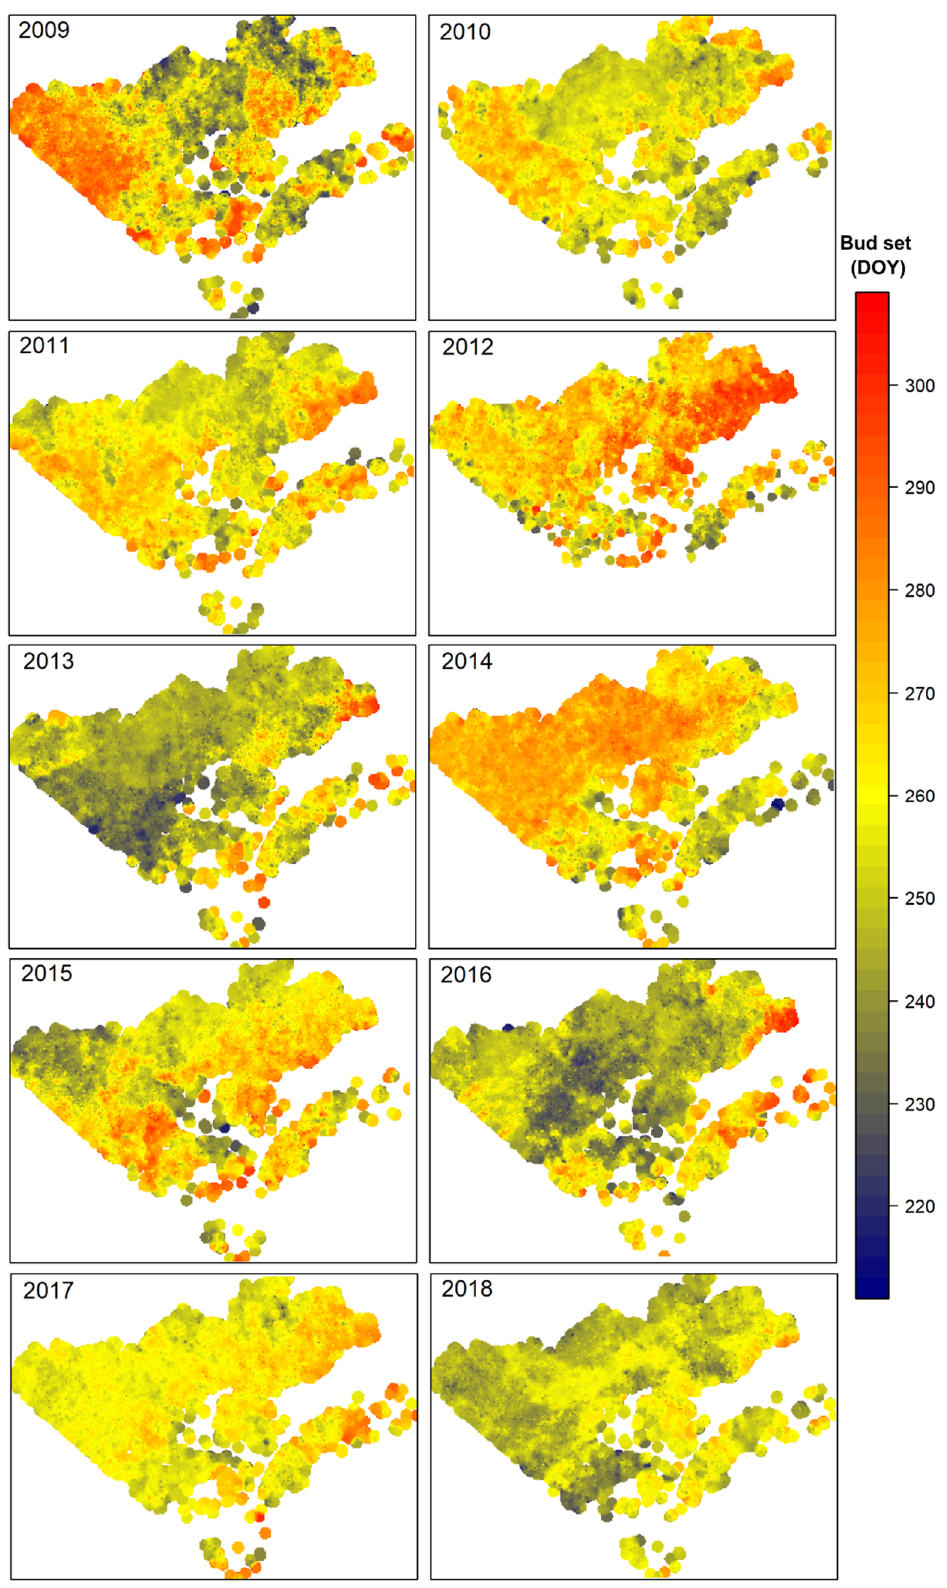
Figure 7. Hotspot analysis of bud set (phase S5) dates (DOY) across boreal black spruce stands in the study area in Quebec, Canada.